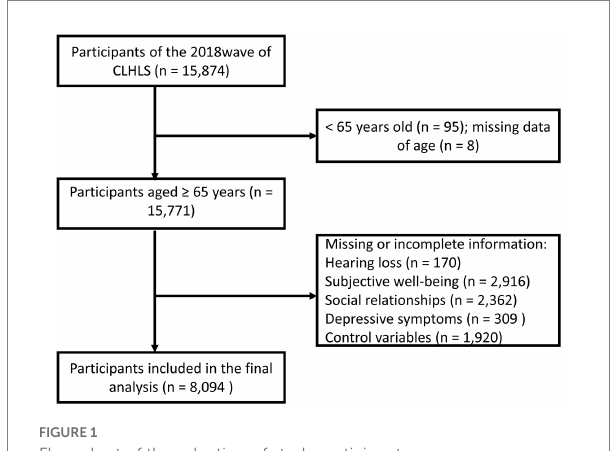
FIGURE 1 Flow chart of the selection of study